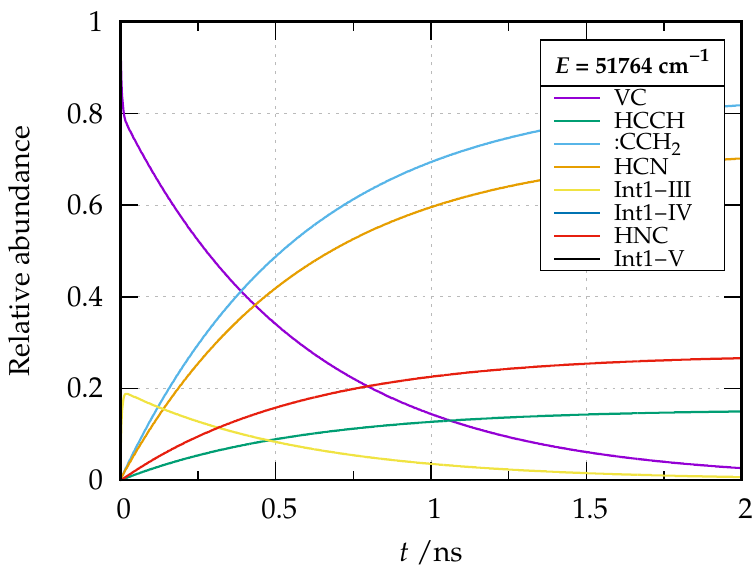
Figure 8. Relative abundance of the species involved in the dissociation of vinyl cyanide as a function of time at energy E = 51764 cm − 1 relative to the reactant zero-point energy.